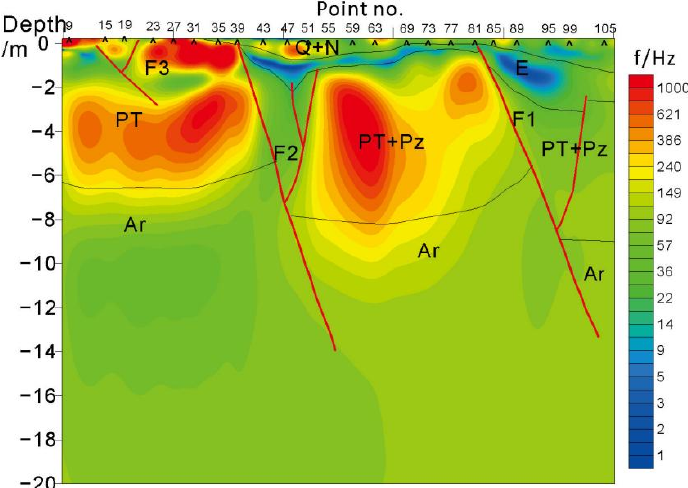
Figure 6. Profile of magnetotelluric interpretation, line SP.